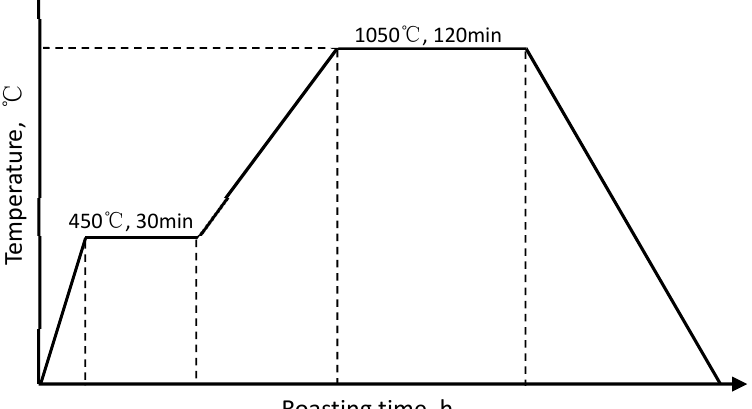
Figure 2. The process of shell roasting.